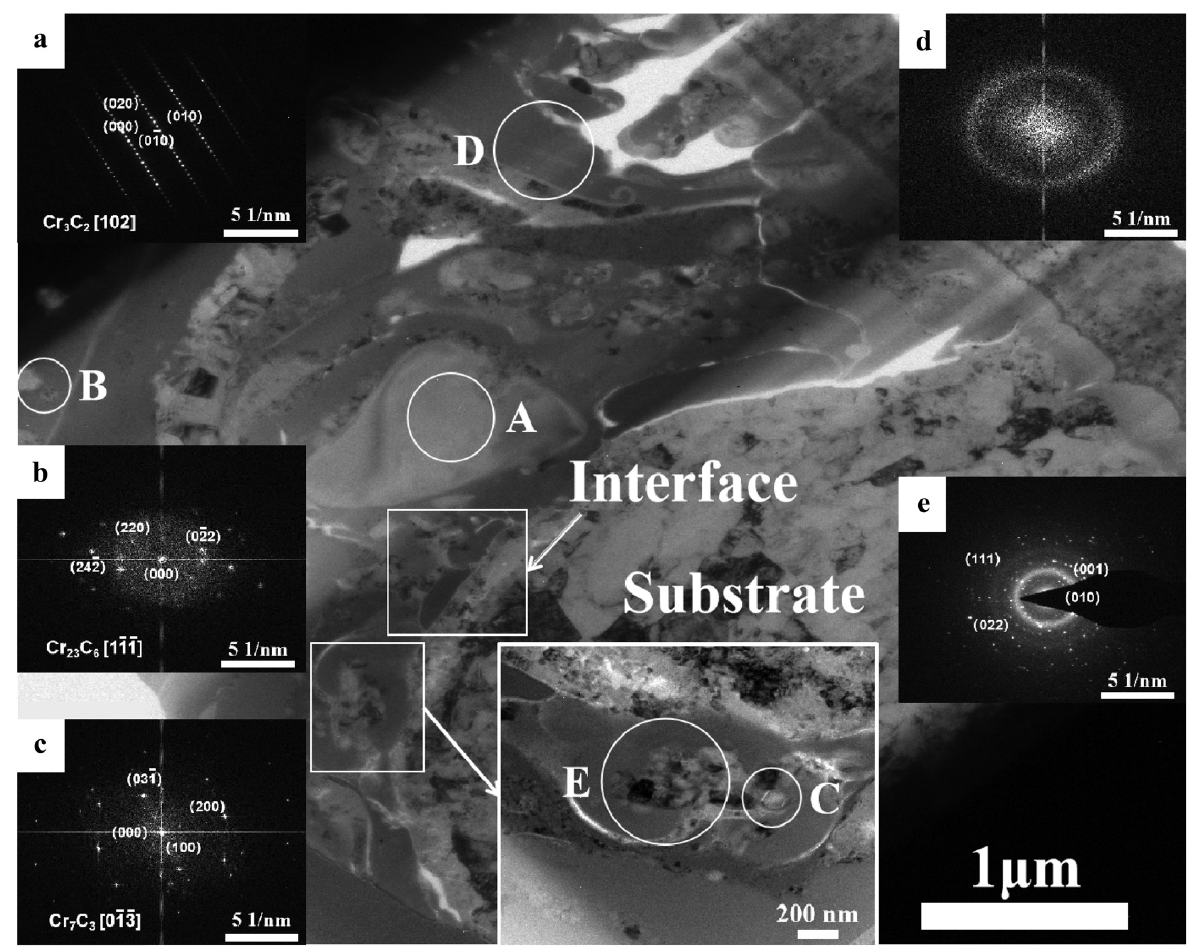
Figure 7: TEM micrograph and di ff raction spot patterns of the cross - sectional MC. ( a ) Cr 3 C 2 , ( b ) Cr 23 C 6 , ( c ) Cr 7 C 3 , ( d ) amorphous phase, ( e ) multiple crystalline phase.